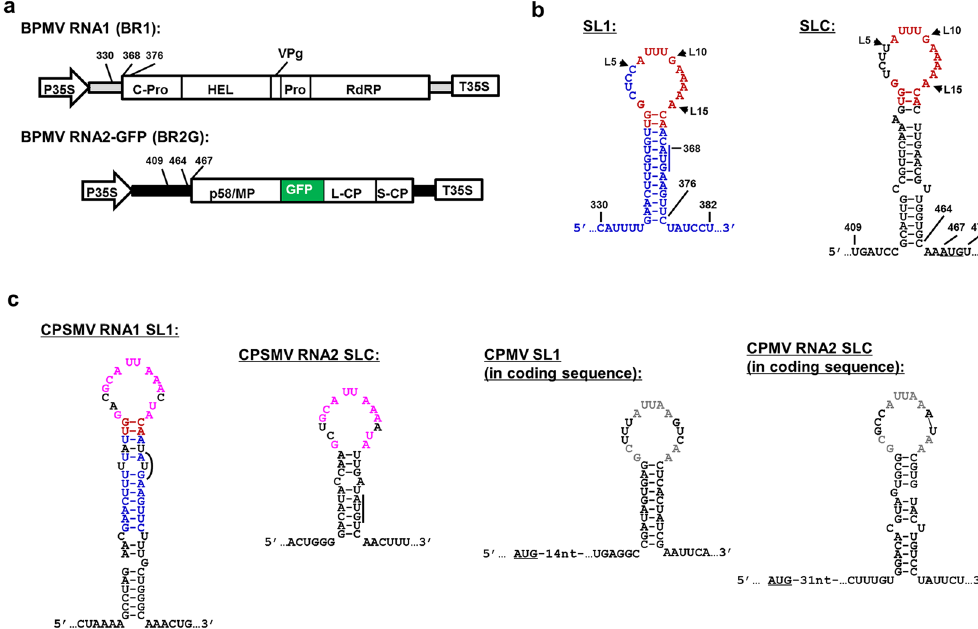
Figure 1. Genome organization of BPMV genomic RNA1 and 2, and the secondary structures of SL1 and SLC in three comoviruses. ( a ) Diagrams of constructs used to launch BPMV RNA1 (BR1) and RNA2 replication. The RNA2-GFP (BR2G) construct is a derivative of RNA2 cDNA with a GFP insert between MP and L-CP 15 . Both BR1 and BR2G cDNAs are flanked by the 35S promoter and terminator (P35S and T35S) of cauliflower mosaic virus to facilitate the transcription of viral RNAs by DNA-dependent RNA polymerase II of host cells. Mature viral proteins known to be processed from the polyprotein precursors are represented with varying sized boxes and the corresponding names. The terminal untranslated regions of BR1 and BR2G are depicted as thick gray and black lines, respectively. The numbers near 5 ′ UTR of BR1 and BR2G delimit the positions of SL1 and SLC, and their intimacy to the polyprotein start codons (also see B). ( b ) Secondary structures of SL1 and SLC. Nucleotides in blue and black are unique to SL1 and SLC, respectively. Those in red are conserved between SL1 and SLC, which are mostly located within the terminal loops. The AUG start codons of BR1 and BR2G polyproteins are underlined. Note that BR1 AUG is part of the stem of SL1. ( c ) Putative SL1 and SLC identified in RNA1 and RNA2 of CPSMV and CPMV. Loop nts shared by SL1 and SLC of CPSMV and CPMV are depicted in purple and gray letters, respectively. Note that CPSMV SL1 and BPMV SL1 share 11 base pairs within the stem (red and blue letters). Also note that both SL1 and SLC of CPSMV encompass the AUG start codons, whereas those of CPMV lie shortly downstream of the polyprotein start